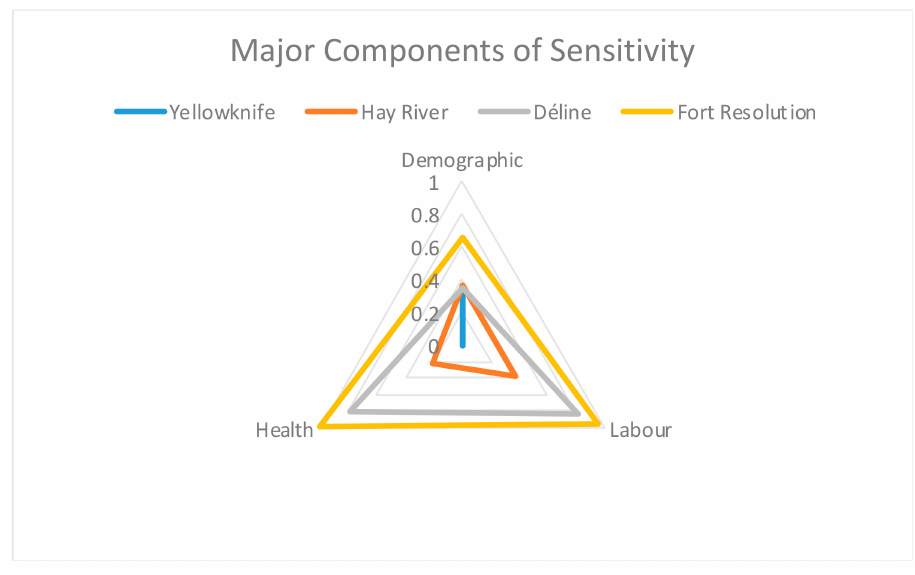
Figure 5. Each community’s sensitivity to the individual major components of sensitivity (demo- graphic, labor, and health).